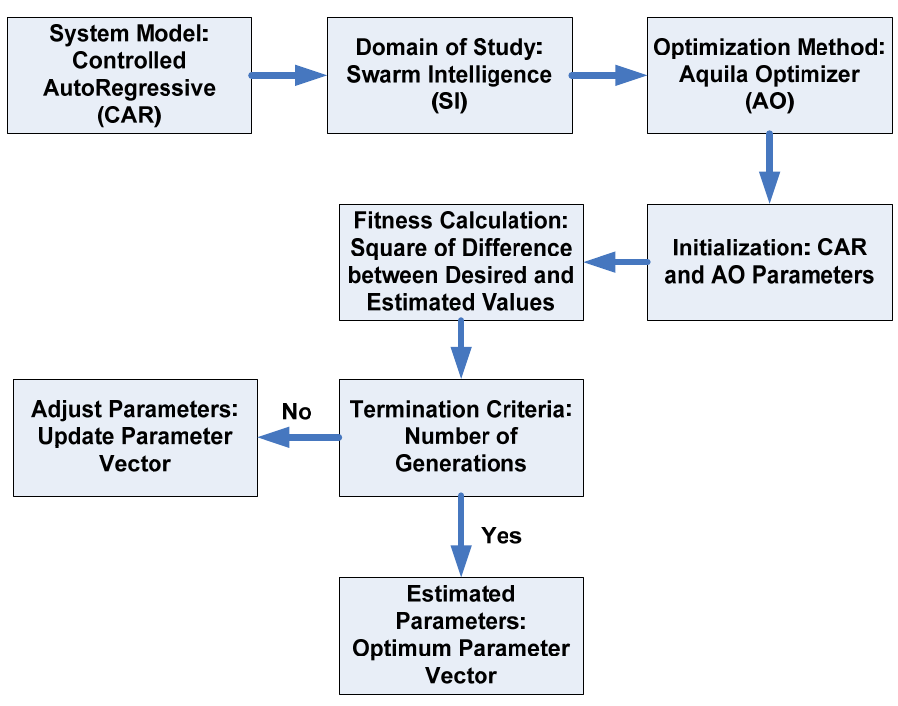
Figure 1. Graphical abstract of the proposed study.